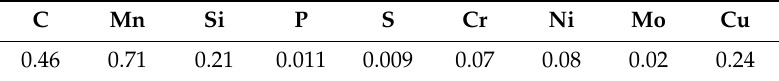
Table 1. Chemical composition of C45 steel used (wt.%).